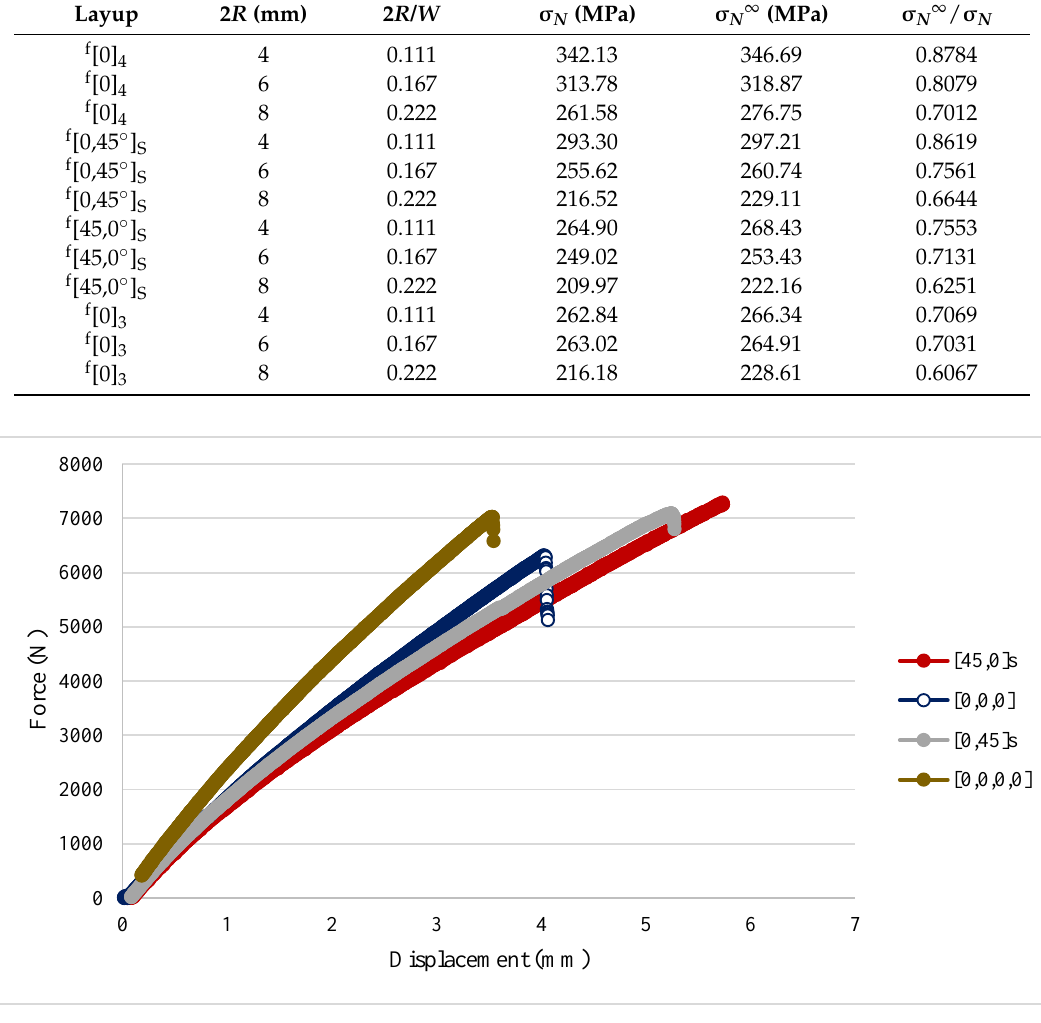
Figure 6. Force-displacement curve of unnotched samples.